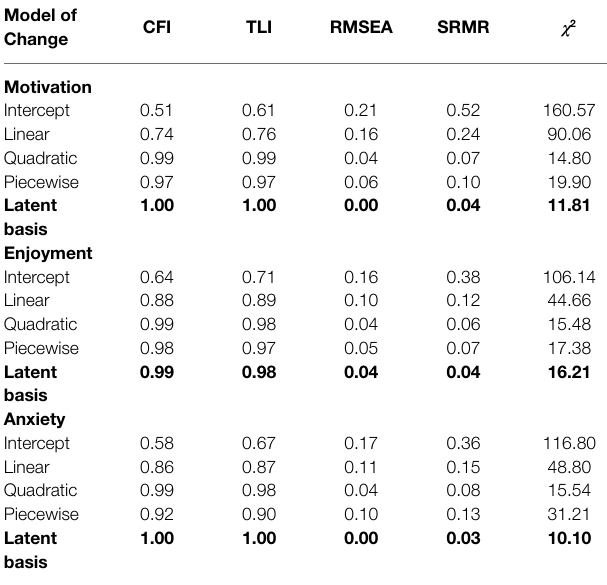
TABLE 1 | Fit statistics for LCGM